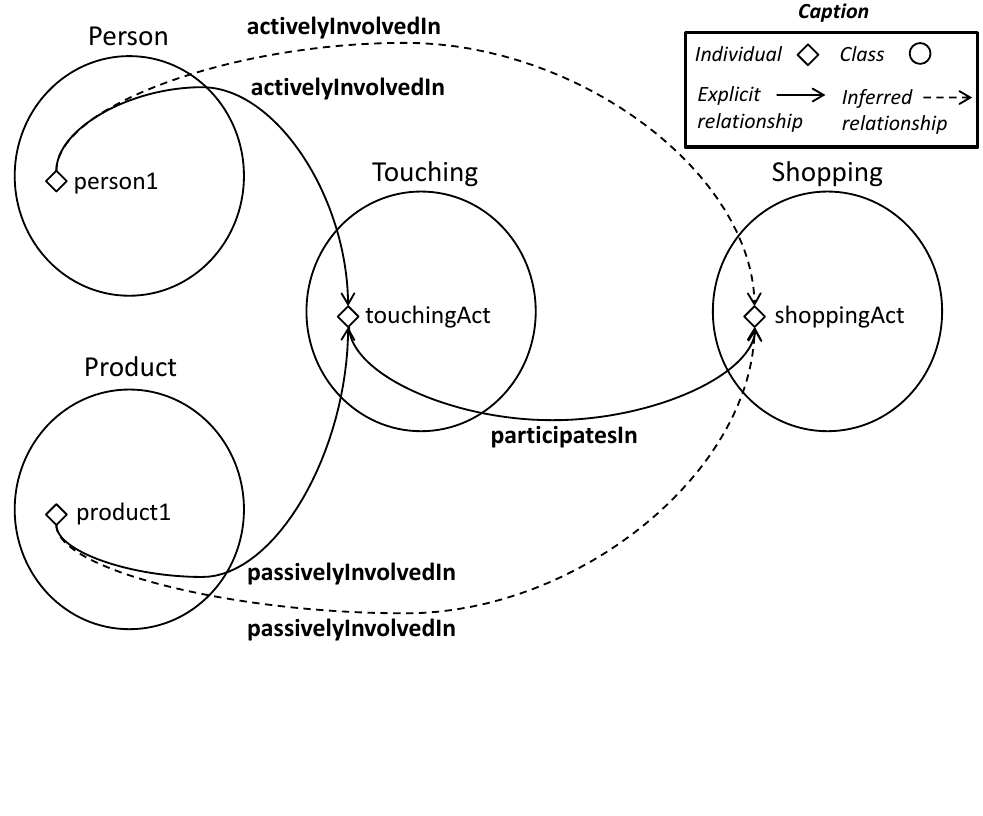
Figure 15. Representation of the inferred involvedIn